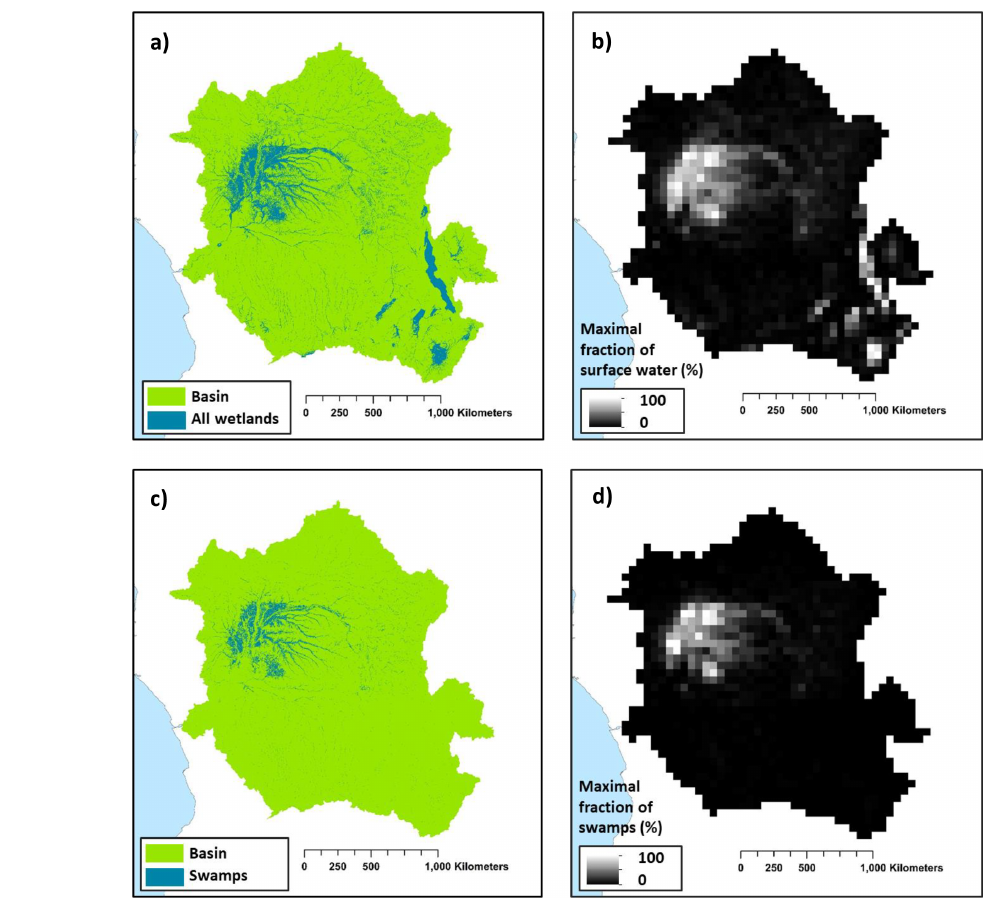
Figure 3. (a) Wetland extent (from Gumbricht et al., 2017). (b) The new maximal fraction of floodplain (MFF) forcing file developed from (a) . (c) The swamp (including fens) category within the Congo Basin from Gumbricht et al. (2017). (d) The new maximal fraction of swamp (MFS) forcing file developed from (c) . Panels (a) and (b) are at the same resolution as the Gumbricht dataset (232m), while panels (b) and (d) are at a resolution of 0.5 ◦ . Note that 0.5 ◦ is the resolution of the subunit basins in ORCHILEAK (Lauerwald et al., 2015), with each 1 ◦ grid containing four